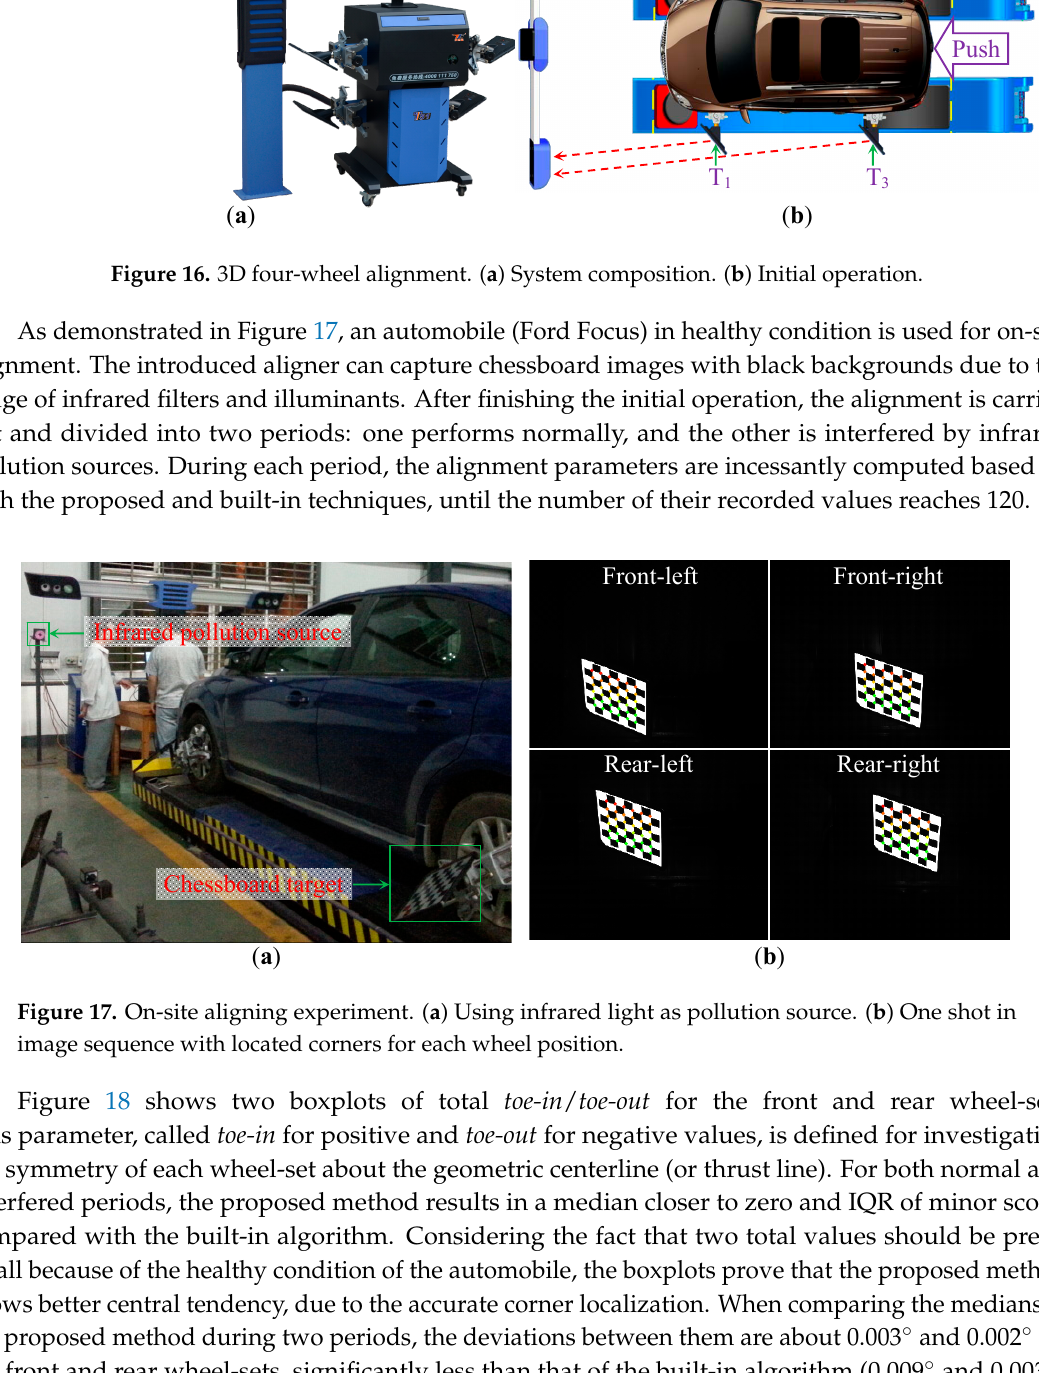
rear-left, and rear-right wheels, respectively. For each image sequence, sub-pixel corners are